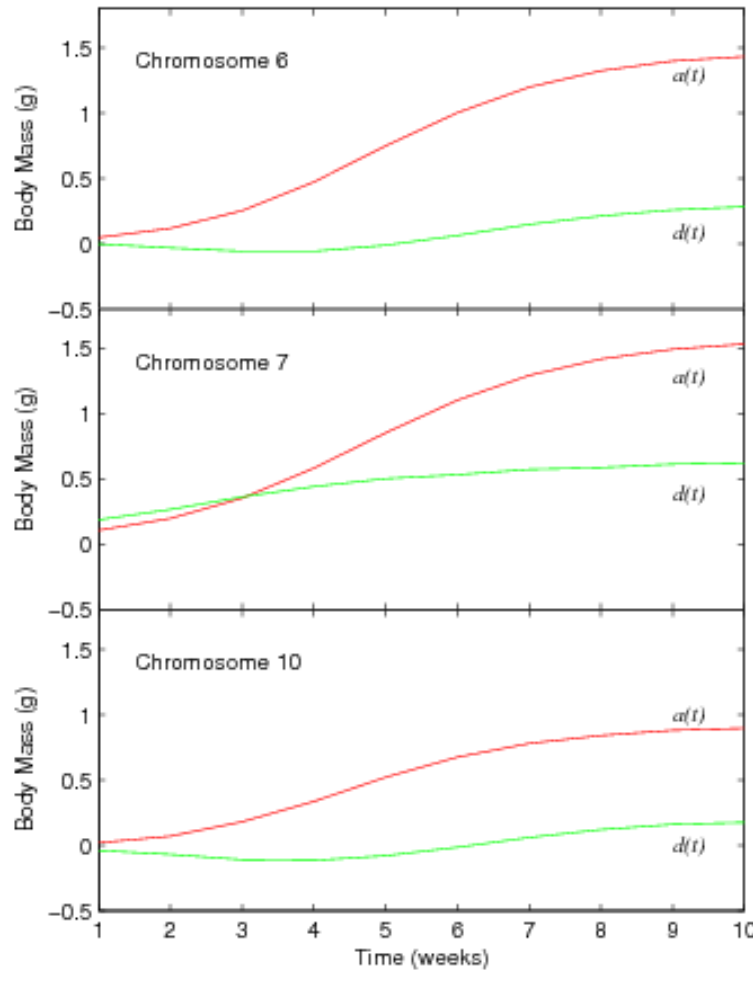
Figure 3. Dynamic changes of the additive and dominant effect due to the QTL located on mouse chromosome 6,7,and 10